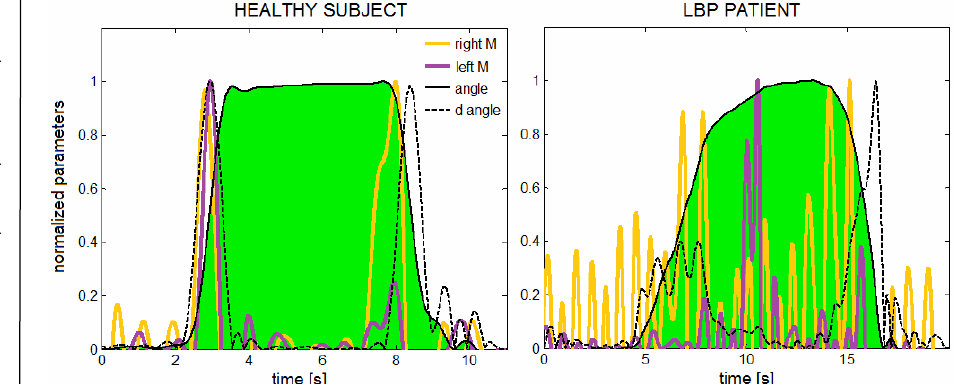
Figure 3 – EMG envelopes for the right and the left Multifidus (M), the trunk angle, and the trunk velocity ( d angle ) for the healthy subject (left panel) and patient P1 (right panel) during trunk flexion/extension. The shaded area is presented for the normalized trunk angle. Slika 3 – Anvelope EMG signala merenih na desnom i levom Multifidus miši ć u ( right M i left M , respektivno), ugao trupa ( angle ) i brzina ugla u trupu ( d angle ) za zdravog ispitani- ka (levi panel) i za pacijenta P1 (desni panel) tokom fleksije/ekstenzije trupa. Osen č ena oblast predstavlja oblik promene ugla trupa.